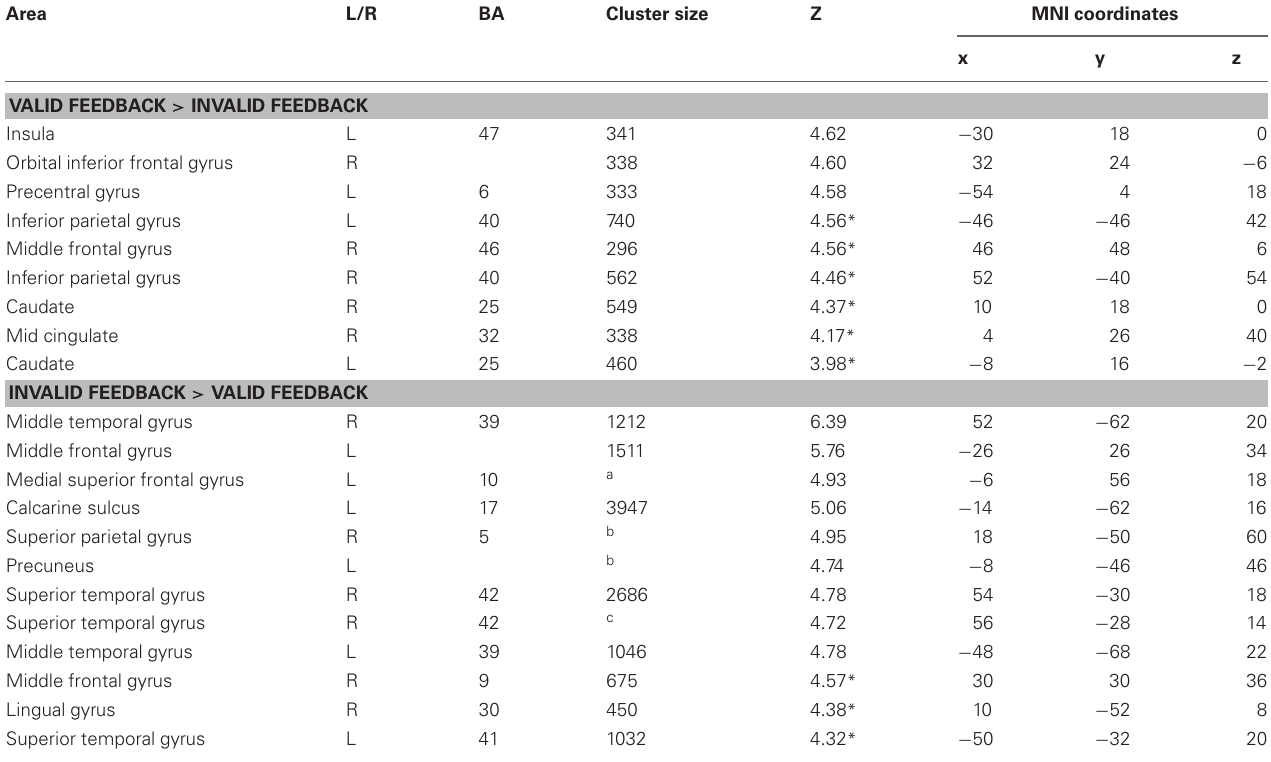
Table 2 | Whole brain analysis for the contrasts valid—invalid feedback, and invalid—valid feedback. Area